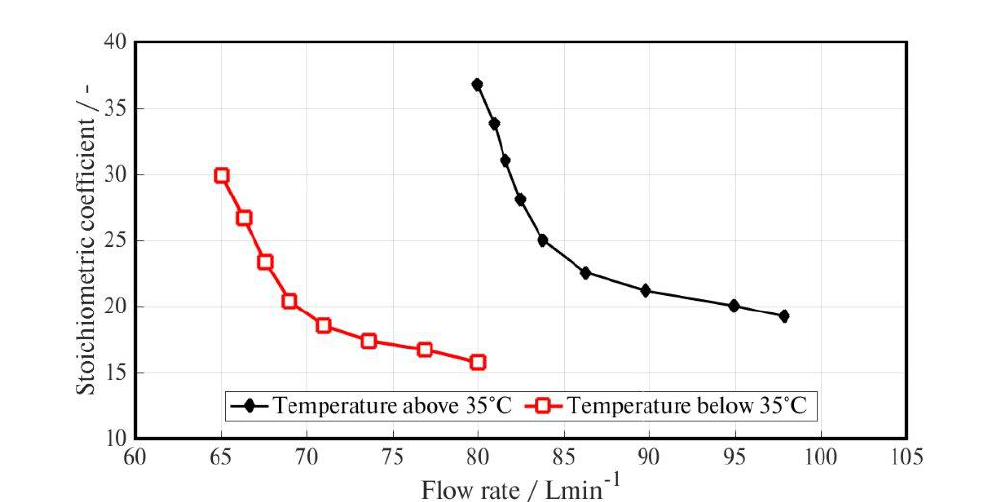
Figure 9. Stoichiometric coefficient vs. flow